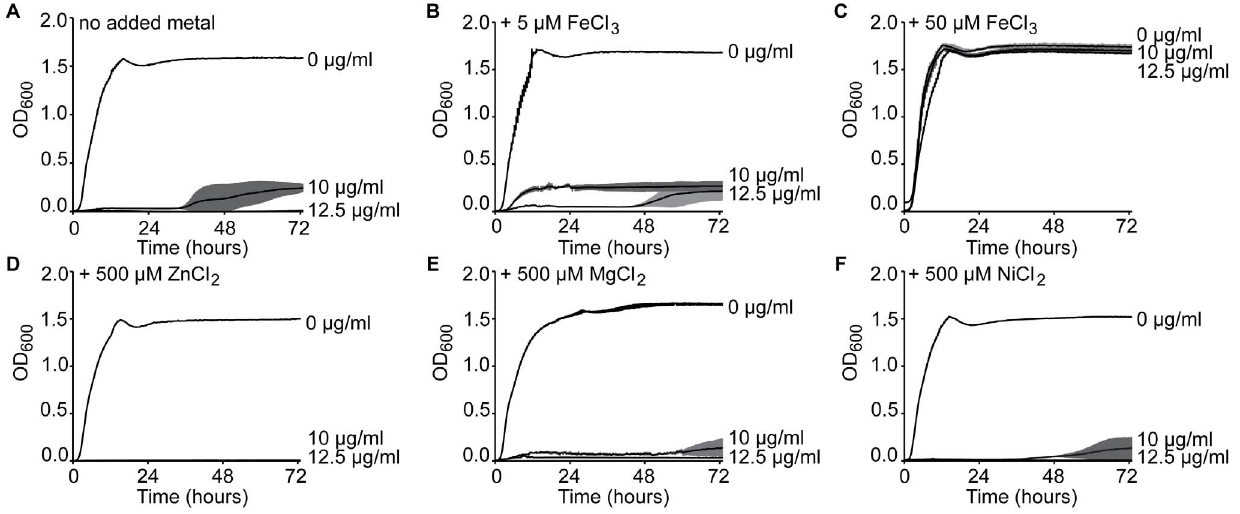
Figure 3. Effects of metals on exposure to ciclopirox for E.coli . Growth curves measured for three independent cultures of ATCC H 25922 TM E. coli grown in (A) LB alone or (B) LB supplemented with 5 m M FeCl 3 , (C) 50 m M FeCl 3 , (D) 500 m M ZnCl 2 , (E) 500 m M MgCl 2, (F) or 500 m M NiCl 2 . Error bars are the standard deviation from the mean.